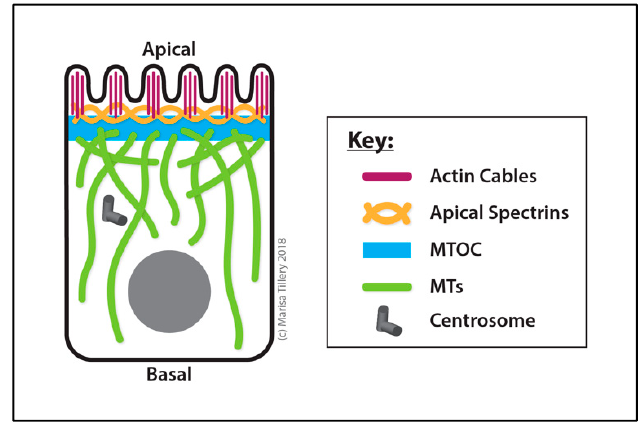
Figure 7. Organization of the ncMTOC in ovarian follicle cells. Shot, not depicted in the illustration, is associated with the apical spectrin cytoskeleton as is the ncMTOC. is associated with the apical spectrin cytoskeleton as is the